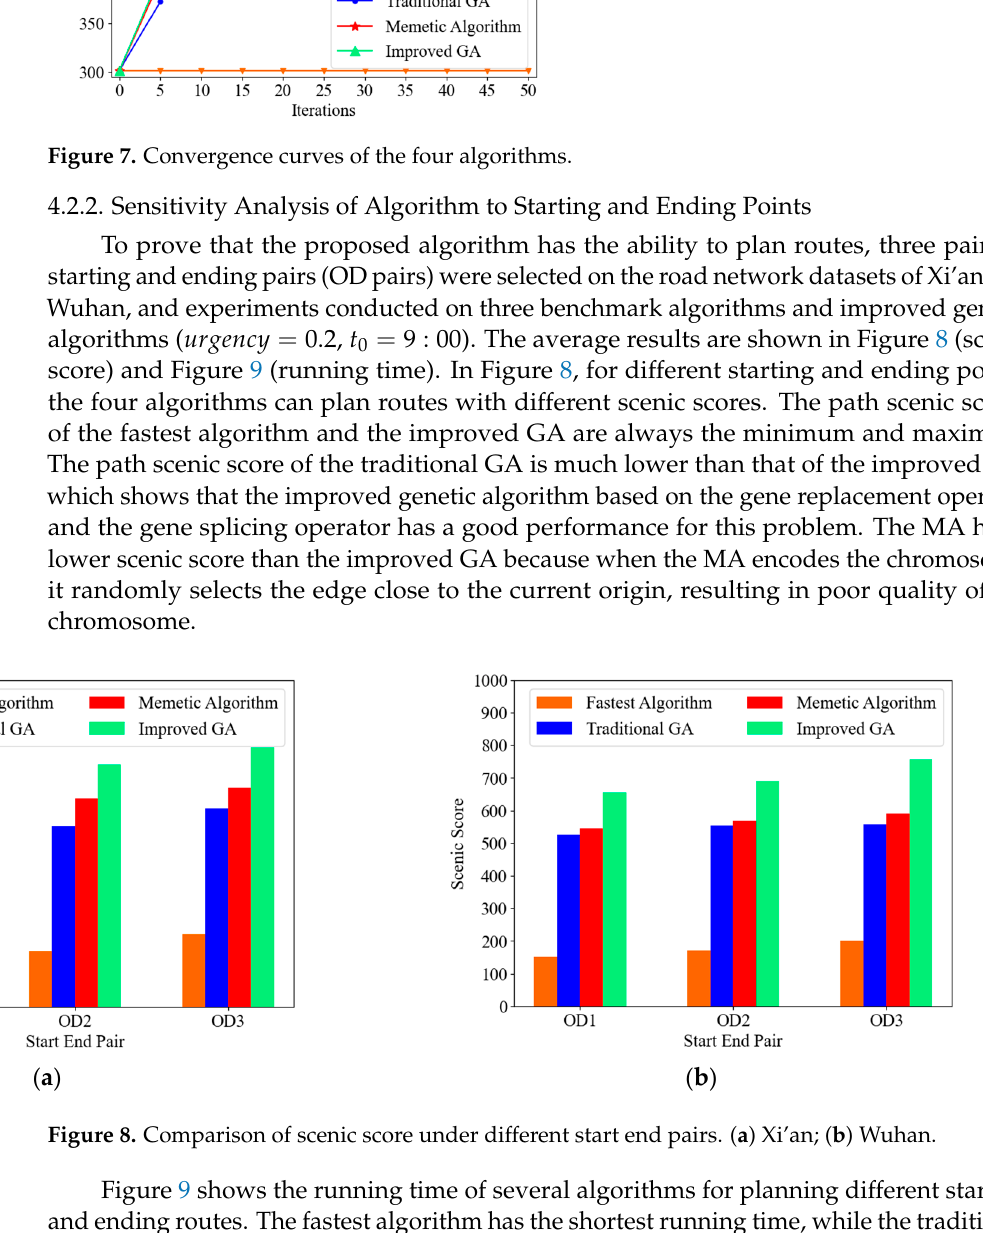
Figure 7. Convergence curves of the four algorithms.